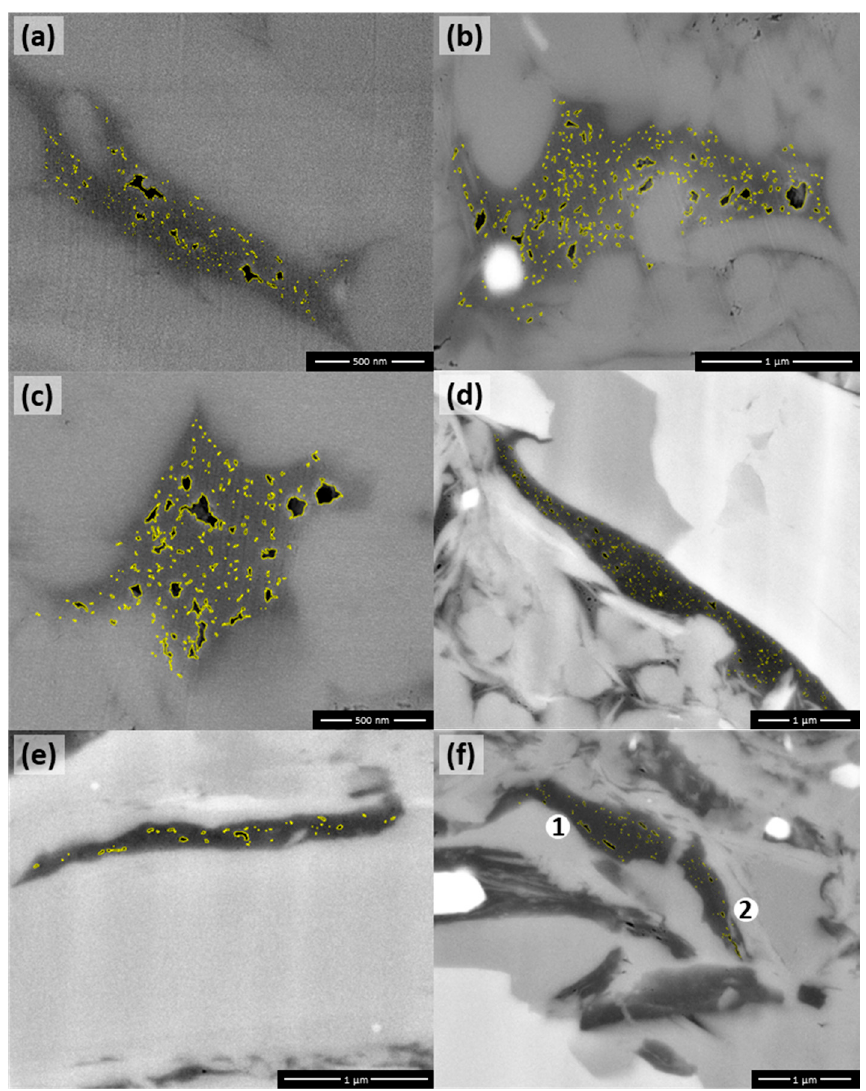
Figure 15. Examples of the third subtype of moderately to strongly deformed pyrobitumen (OM VI) from Longmaxi-Wufeng Shale, Sichuan Basin. ( a ) SEM image JY1S-3-6 (well ID-sample no.-image no.); ( b ) SEM image JY1S-13-05; ( c ) SEM image JY1S-14-18; ( d ) SEM image JY8S-5-07; ( e ) SEM image JY8S-5-16; and ( f ) SEM image JY8S-10-03. The boundary of OM-hosted pores was outlined by yellow color.